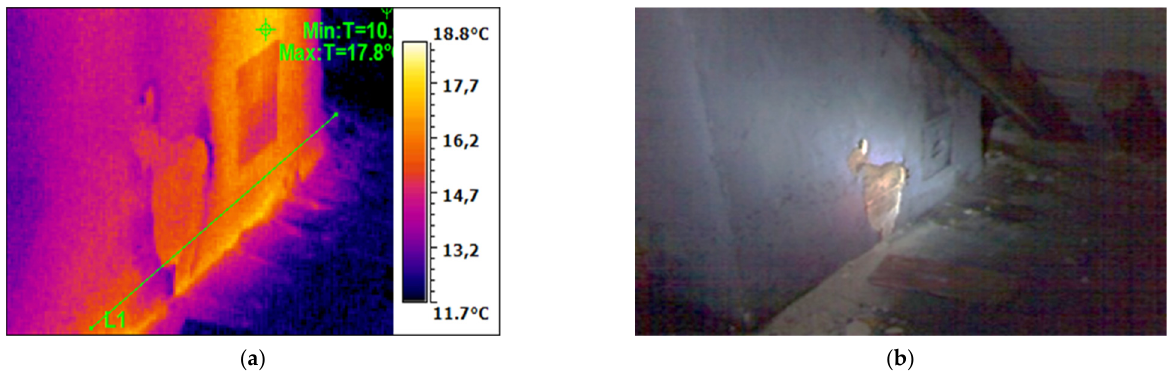
Figure 6. Thermal ( a ) image of the temperature distribution on the surface of the chimney wall in visible light ( b ).